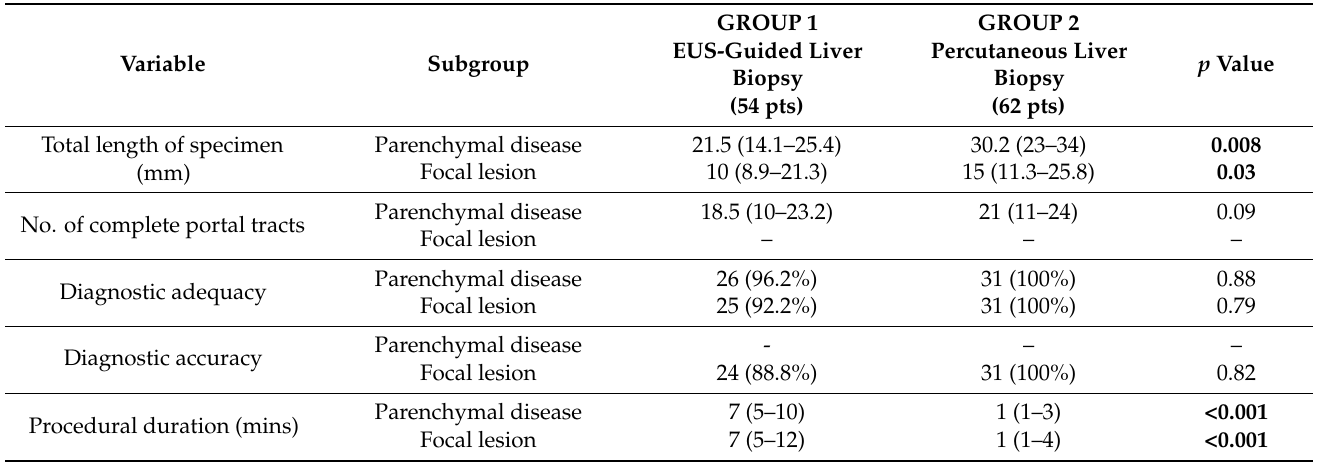
Table 3. Subgroup analysis according to indication to biopsy (parenchymal disease versus focal